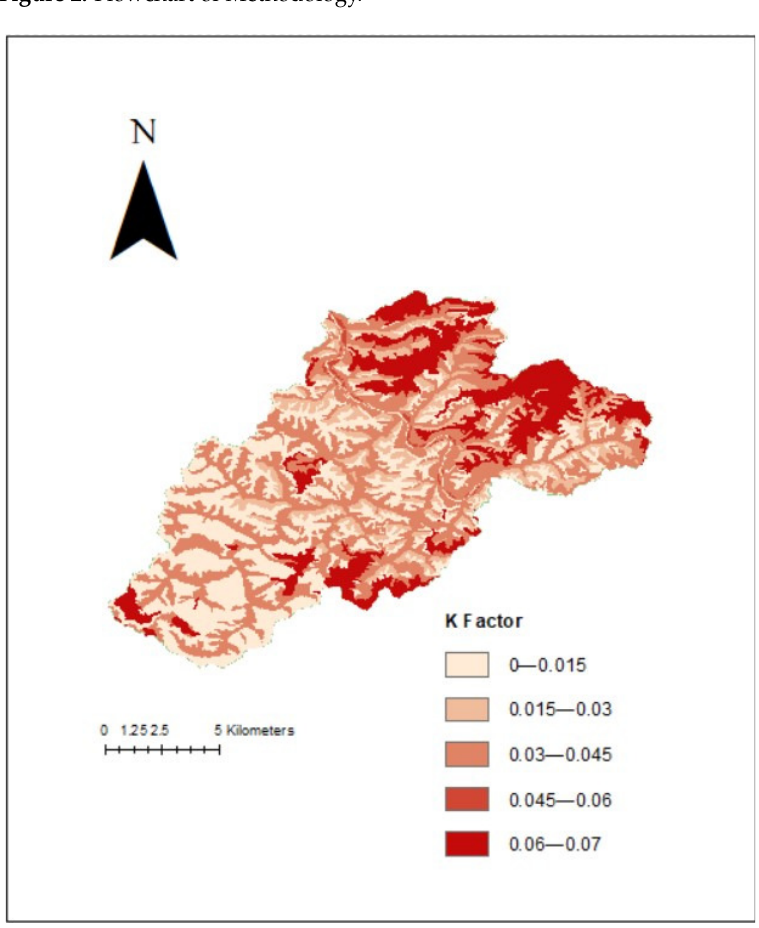
Figure 3. Map of the K factor values across the watershed.